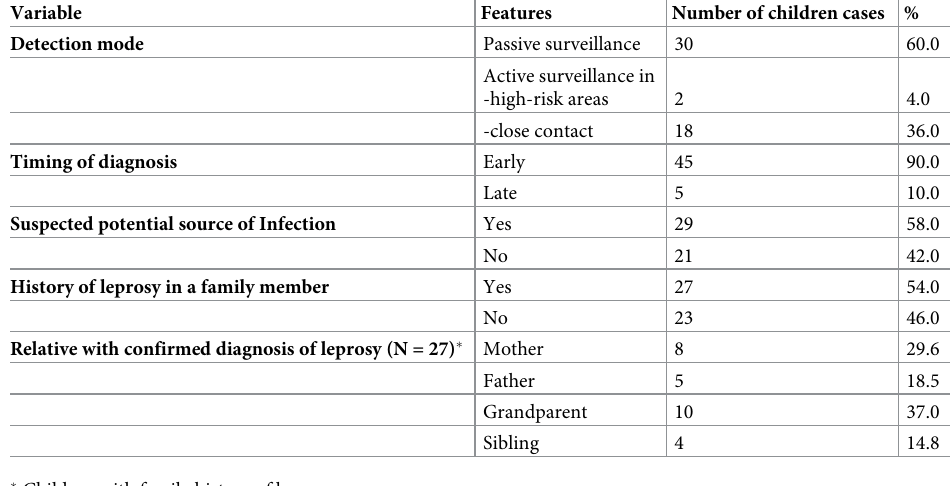
Table 5. Childhood leprosy cases according to surveillance and epidemiological screening (N = 50).